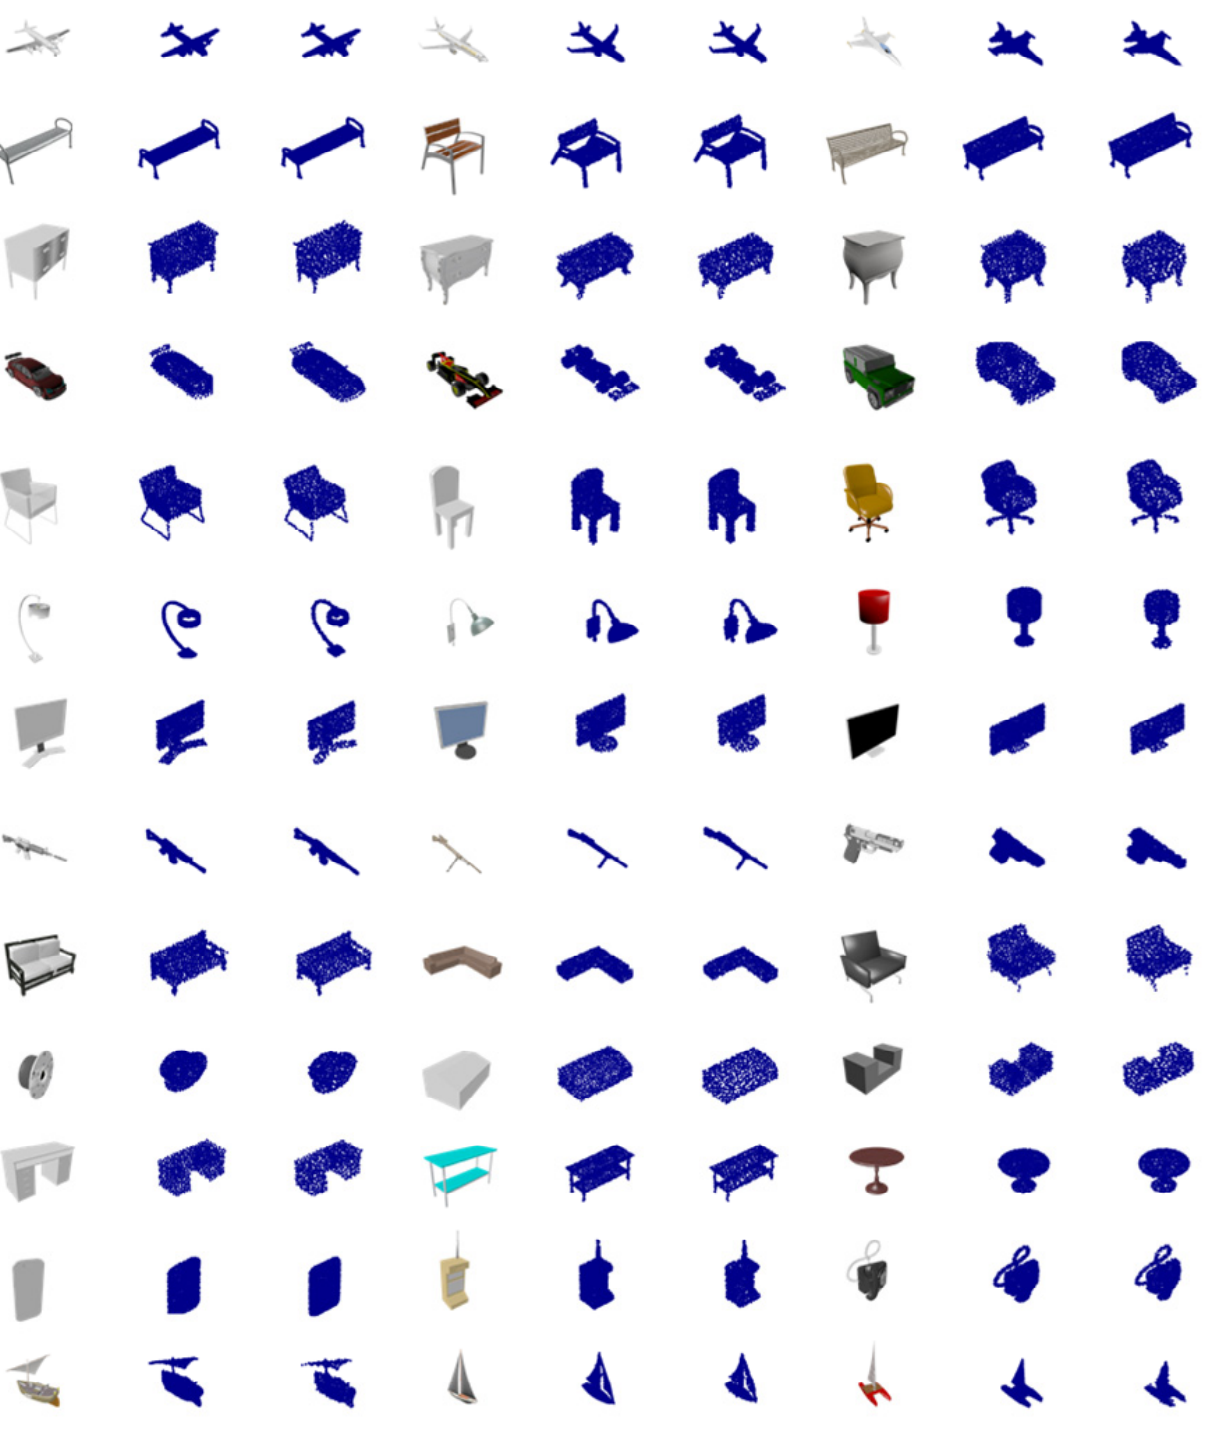
Figure 5. Visualization of our predictions on ShapeNet.